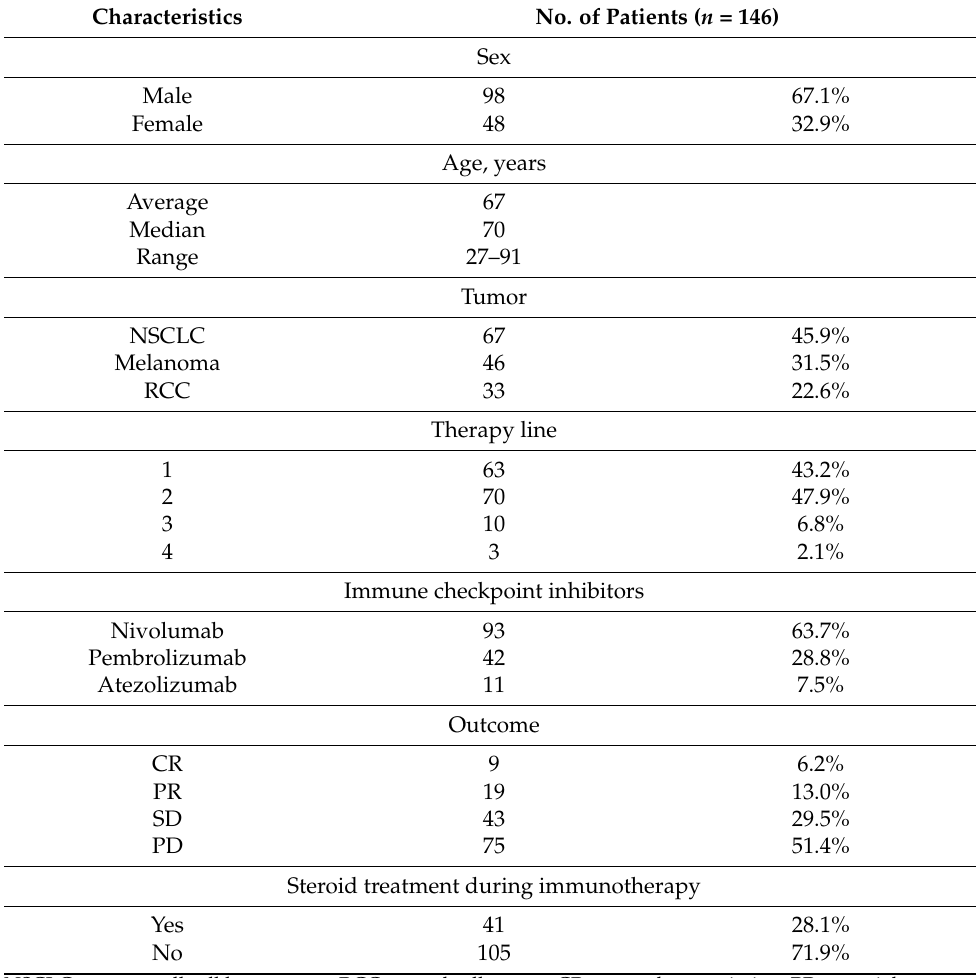
Table 1. Clinical features of the study